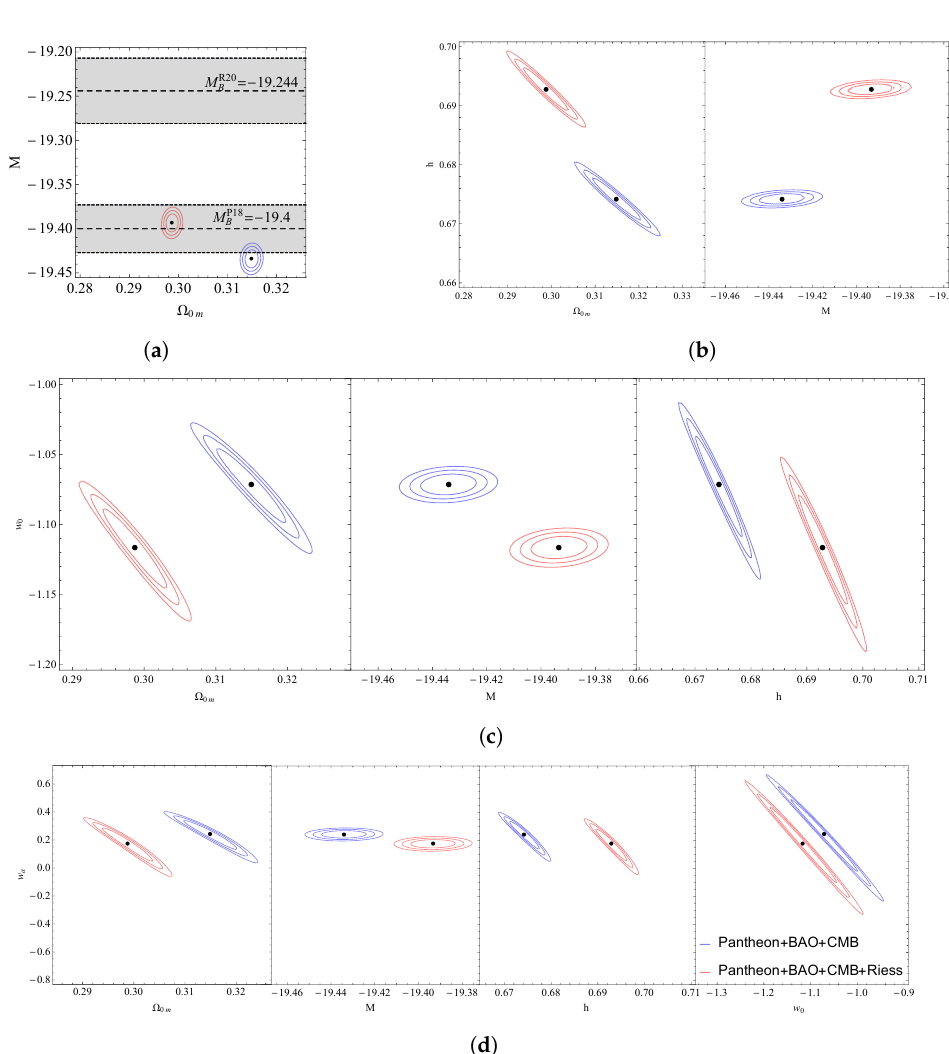
Figure 22. Confidence contours for the CPL model with the addition of the Riess point: ( a ) The 1 σ − 3 σ confidence contour in the parametric space ( M − Ω 0 m ) . ( b ) The 1 σ − 3 σ confidence contours in the parametric spaces ( h − Ω 0 m ) and ( h − M ) . ( c ) The 1 σ − 3 σ confidence contours in the parametric spaces ( w 0 − Ω 0 m ) , ( w 0 − M ) and ( w 0 − h ) . ( d ) The 1 σ − 3 σ confidence contours in the parametric spaces ( w a − Ω 0 m ) , ( w a − M ) , ( w a − h ) and ( w a − w 0